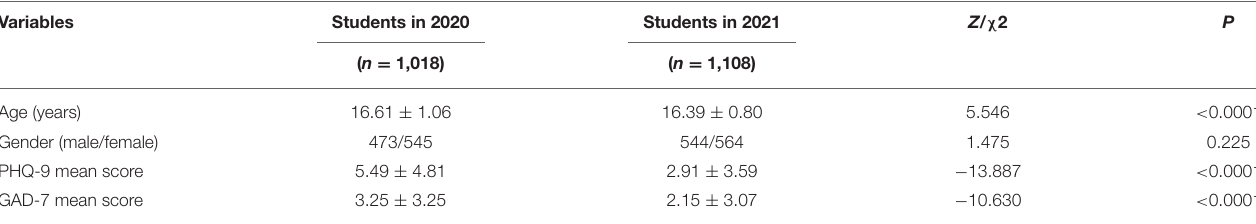
TABLE 5 | The demographic characteristics and depression and anxiety symptoms differences between high school students in 2020 and 2021.